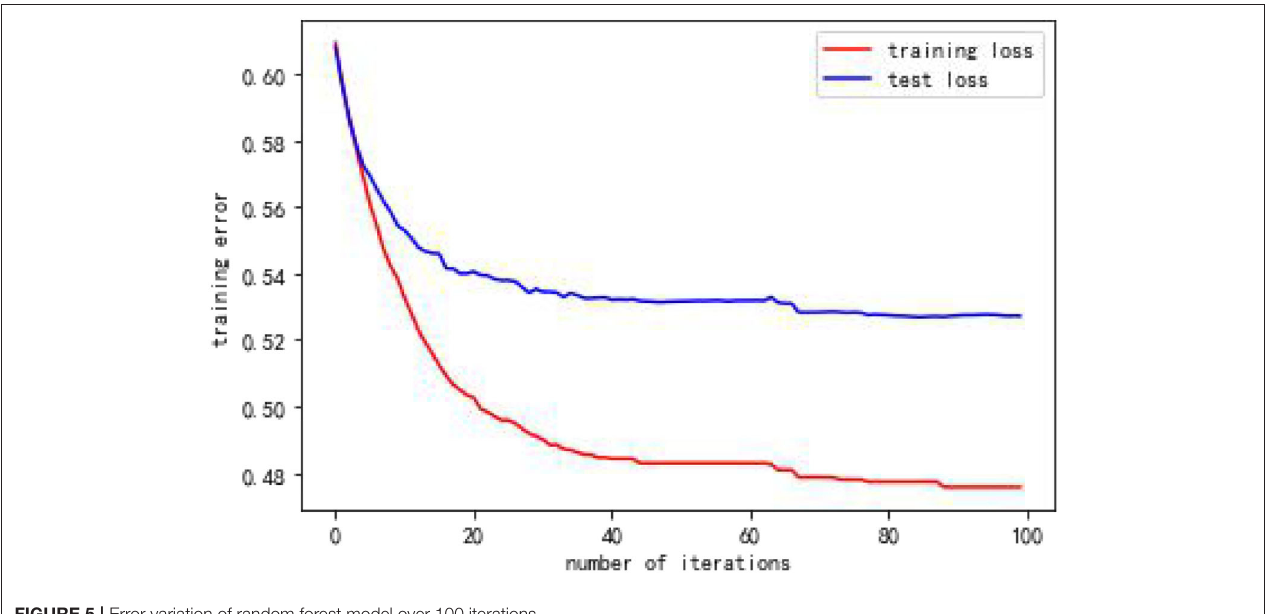
FIGURE 5 | Error variation of random forest model over 100 iterations.